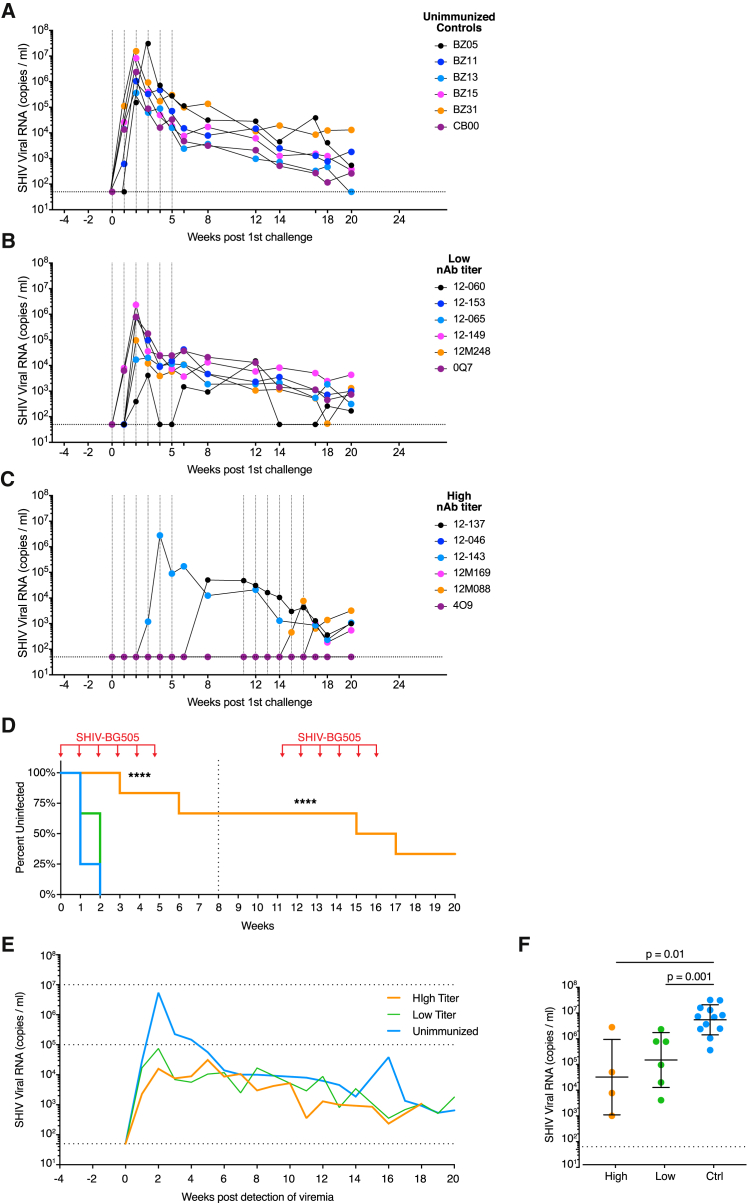
High nAb Titer Animals Show Robust Protection from SHIVBG505 Challenge(A–C) Viral loads of animals throughout the challenge schedule: unimmunized concurrent controls (A), low nAb titer (B), and high nAb titer (C) macaques. IR challenges are indicated with vertical dotted lines. Horizontal dotted lines denote the limit of detection.(D) Kaplan-Meier curves indicating percent uninfected animals over the duration of the study. Challenge time points are indicated with red arrows. Significance levels are indicated with stars; ∗∗∗∗p < 0.0001. Statistics were calculated for both the first (dotted line at week 8) and second challenge sets (see Table S3).(E) Geometric mean viral loads of indicated groups, normalized to the detection of viremia in the blood. Horizontal lines at 105 and 107 viral RNA copies/mL serve as visual aids.(F) Comparison of peak viral loads between high nAb titer (High), low nAb titer (Low), and unimmunized (Ctrl) animals. Geometric mean viral loads are shown with geometric standard deviations. Significant differences were determined using two-tailed Mann-Whitney U tests.See also Figure S2.